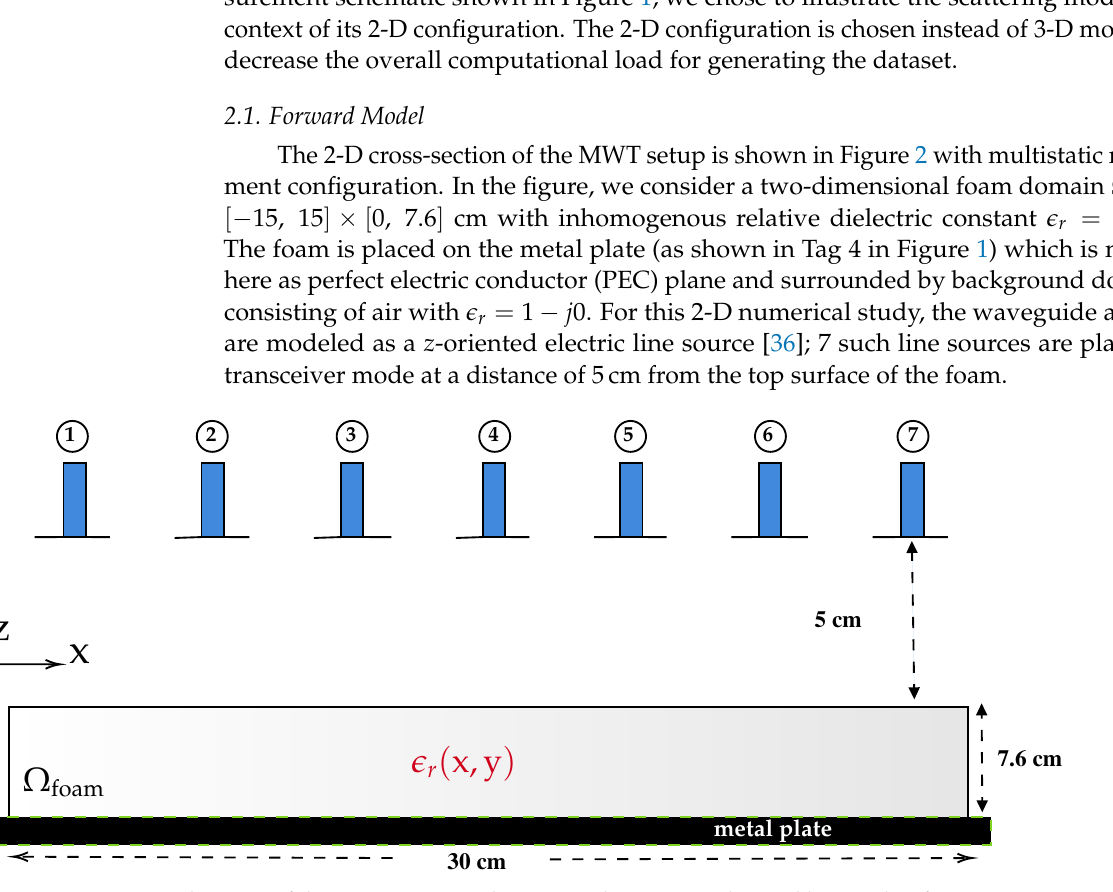
Figure 2. 2-D schematic of the MWT setup with waveguide antennas denoted by number from 1, 2, . . .